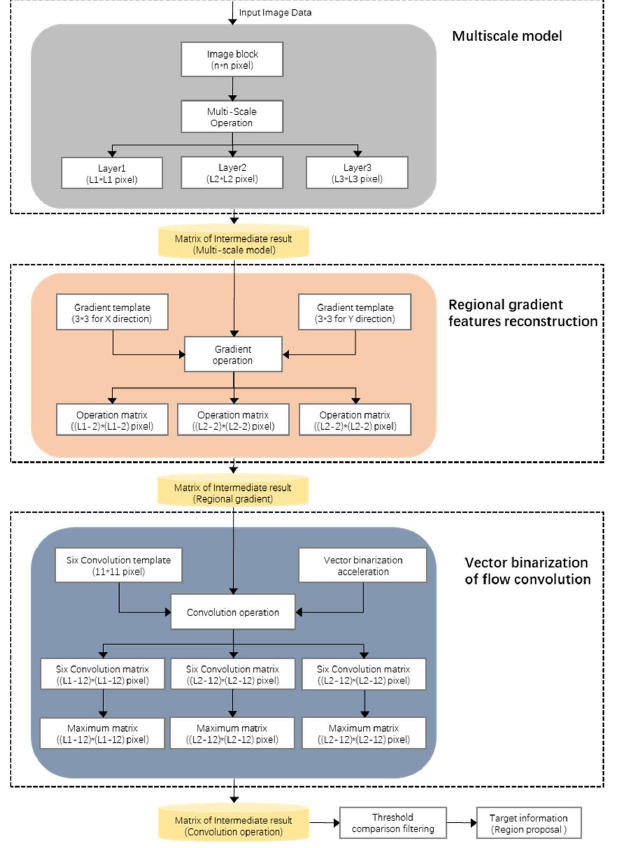
Figure 1. Schematic of the candidate-region extraction process.